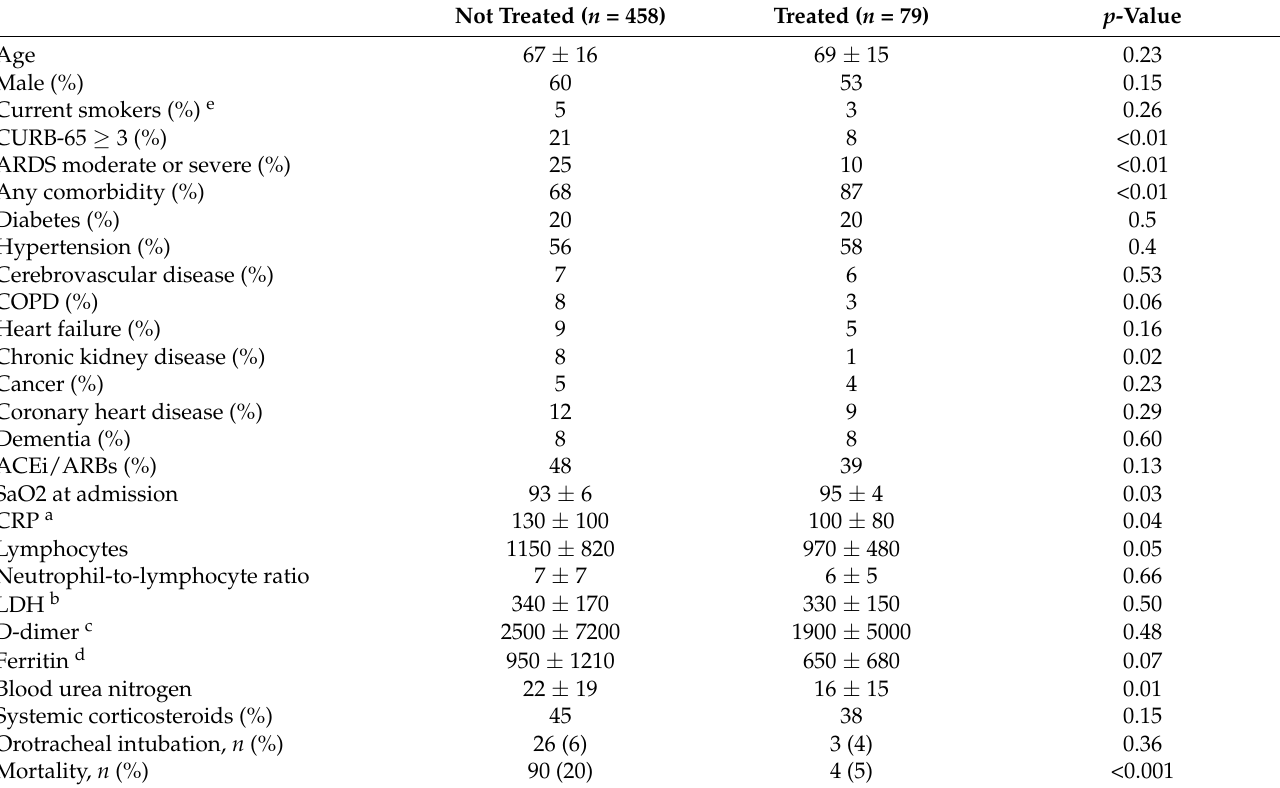
Table 1. Baseline characteristics of patients treated or not with calcifediol, days of hospitalization, and mortality after 30 days of follow-up.